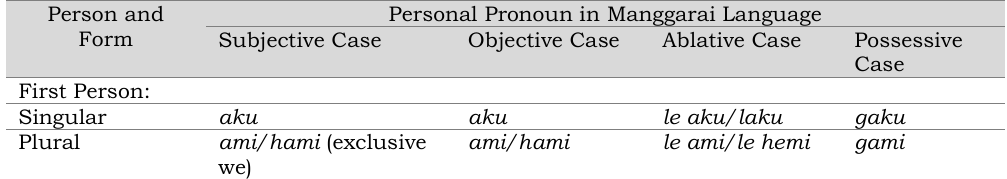
Table 3. The form of personal pronouns in the Manggarai